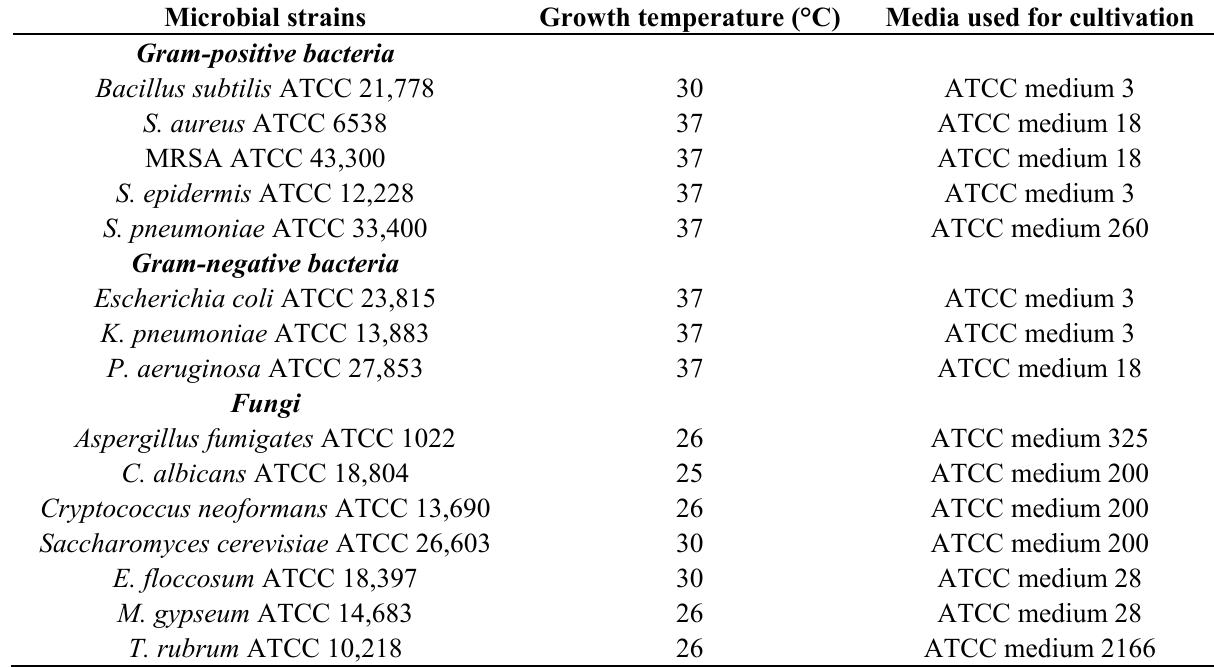
Table 1. Microbial strains assayed for antimicrobial